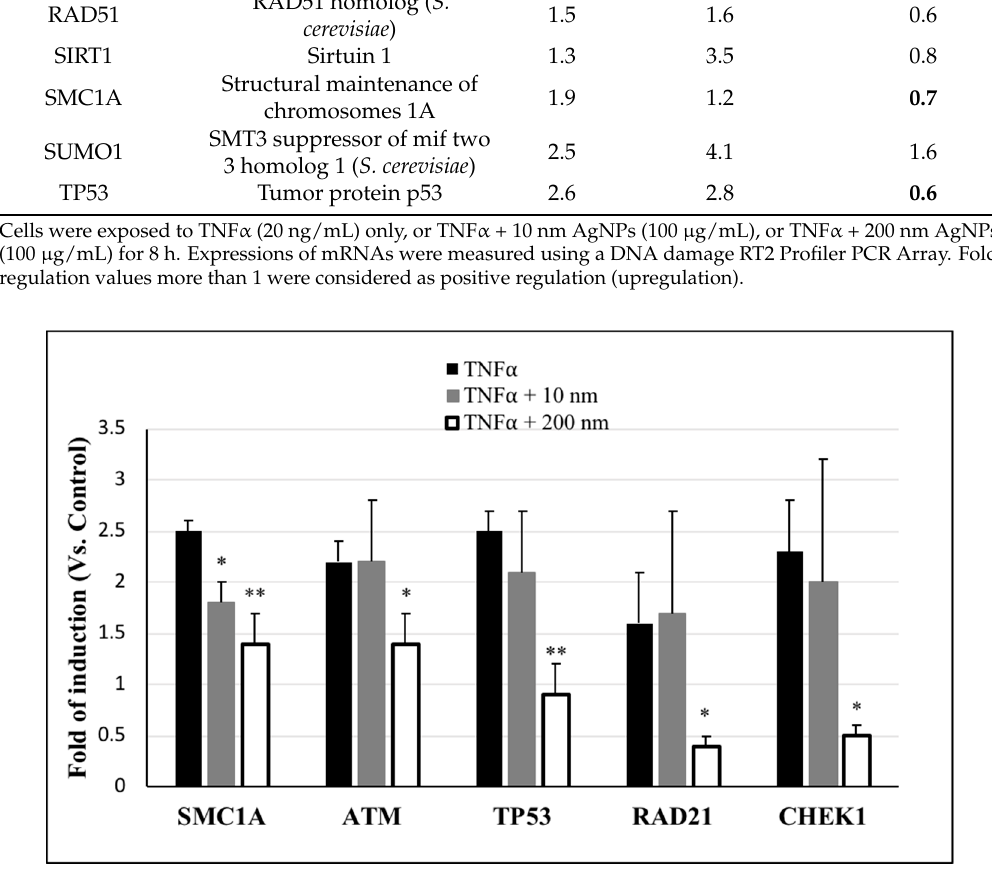
Figure 5. Expression of DNA damage marker mRNAs in NCI-H292 cells. Cells were exposed to TNF α (20 ng/mL) only, TNF α + AgNPs 10 nm (100 µ g/mL), or TNF α + AgNPs 200 nm (100 µ g/mL) for 8 h. Expressions of mRNAs were measured using RT-PCR. The results are shown as means ± SD, n ≥ 3, for each group; *0.01 < P < 0.05, ** P < 0.01, and each represents significant differences compared to the corresponding TNF α -exposed group.